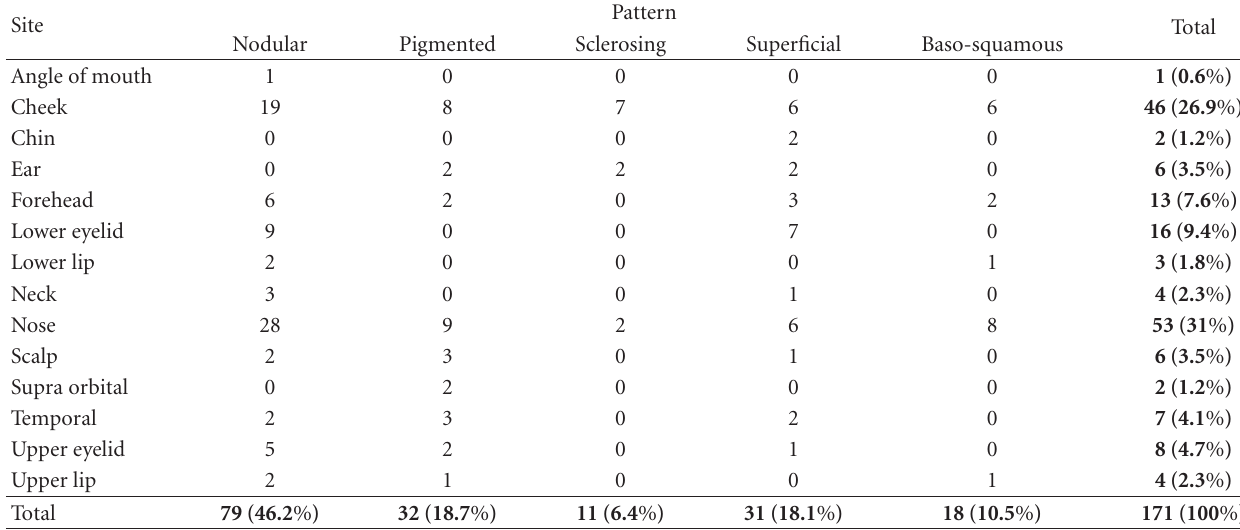
Table 1: Showing association of pattern and site along with their frequencies and